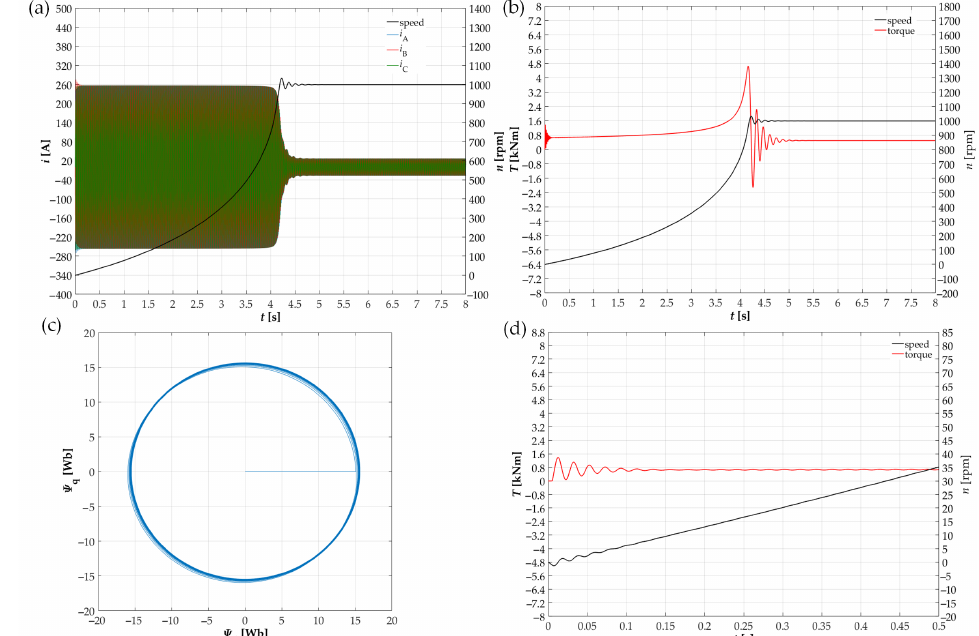
Figure 10. Waveforms of physical quantities for direct start-up, with a delay of switching on the voltage phase of t delay = 5 ms and constant load momentum T o = 500 Nm: ( a ) time waveforms of the stator currents in three phases and rotational speed; ( b ) time waveform of the electromagnetic torque and rotational speed; ( c ) hodograph of stator fluxes, ( d ) segment of the time waveform of the electromagnetic torque and rotational speed, in the first moment of